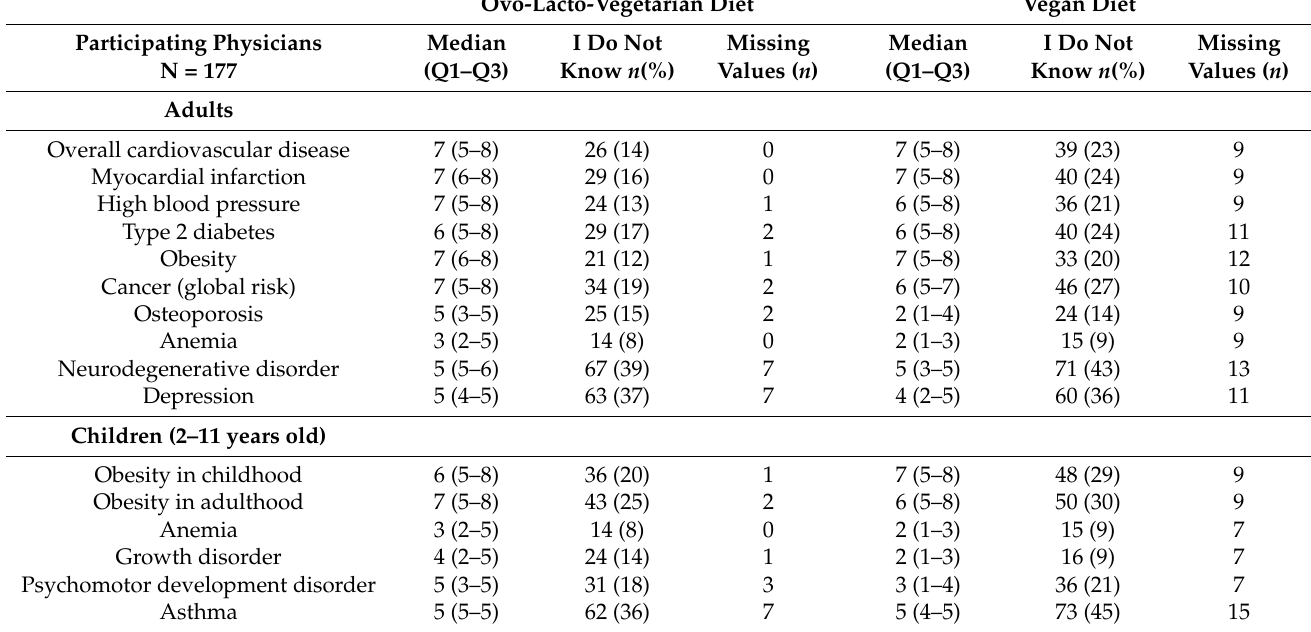
Table 2. Effects of an ovo-lacto-vegetarian or vegan diet “conducted in the best possible way” on adults and children, according to physicians. (0 = harmful effect; 5 = neutral effect; 10 = protective effect; n